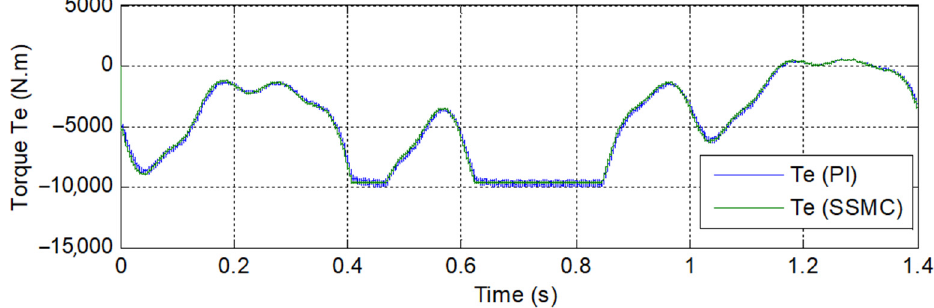
Figure 9. Stator current.